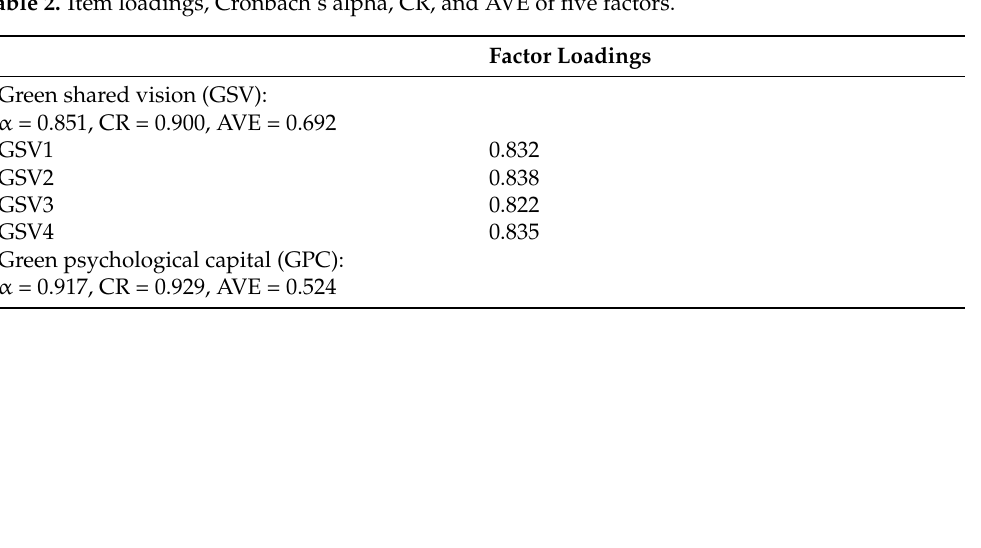
Table 2. Item loadings, Cronbach’s alpha, CR, and AVE of five factors.